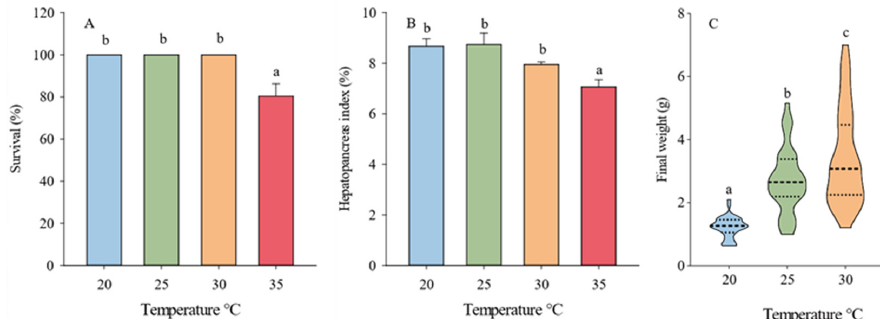
Figure 1. Effects of different temperatures (20-35 °C) on survival rate ( A ), hepatopancreas index ( B ), and final weight ( C ) of juvenile mud crabs. Values are expressed as mean ± SD ( n = 3). Different superscripts indicate significant differences between treatments ( p < 0.05).